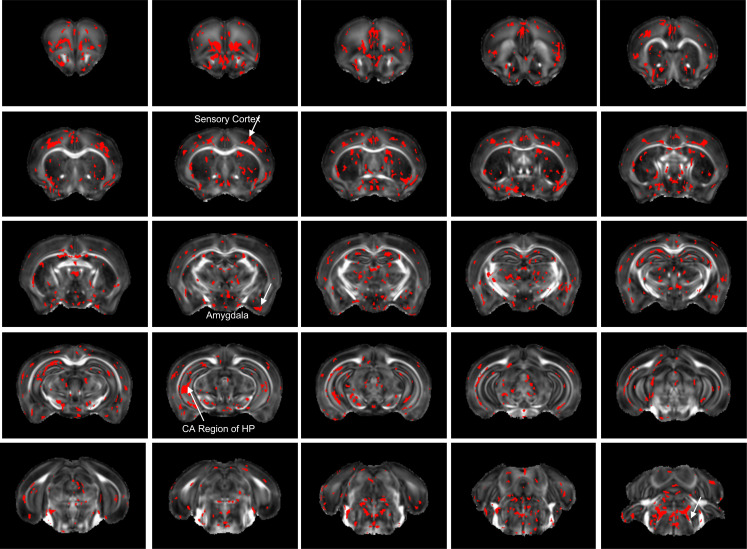
Areas that show potentially significant interactions between unpredictable postnatal stress and sex for fractional anisotropy (FA) (p<0.05 uncorrected, minimal cluster size = 20 voxels).n = 6 per rearing condition and sex.